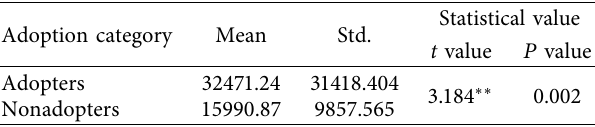
Table 7: In general, the mean gross annual income (ETB) of adopters and nonadopters of agroforestry